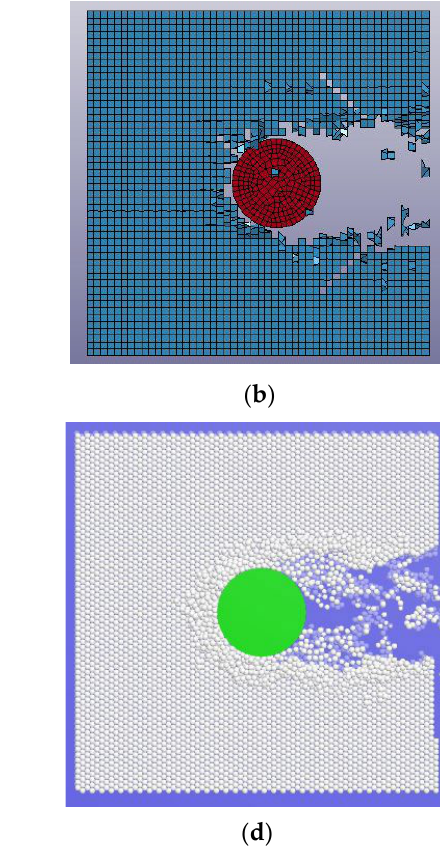
Figure 5. Simulation of interaction between cylinder structure and level ice. ( a ) Schematic diagram of